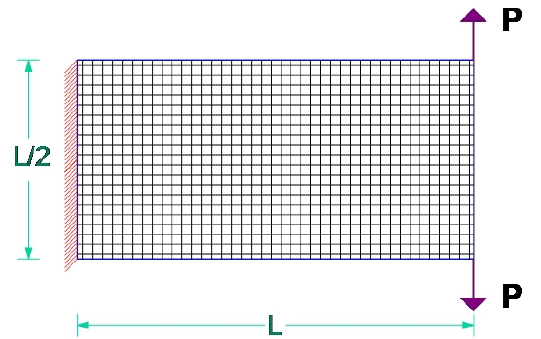
Figure 13. Definition of test example E.